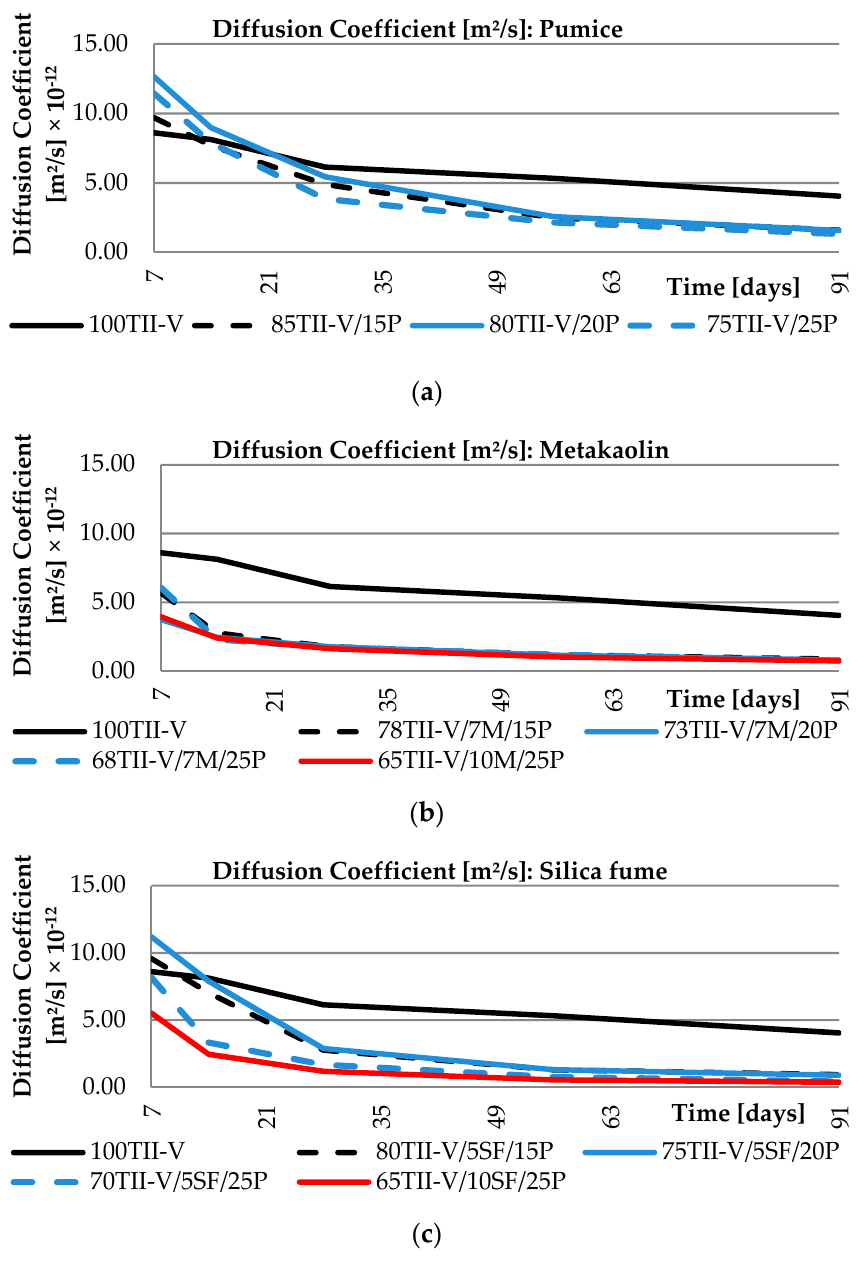
Figure 5. Time-dependent variation of diffusion coefficient: ( a ) pumice group; ( b ) metakaolin group; ( c ) silica fume group.